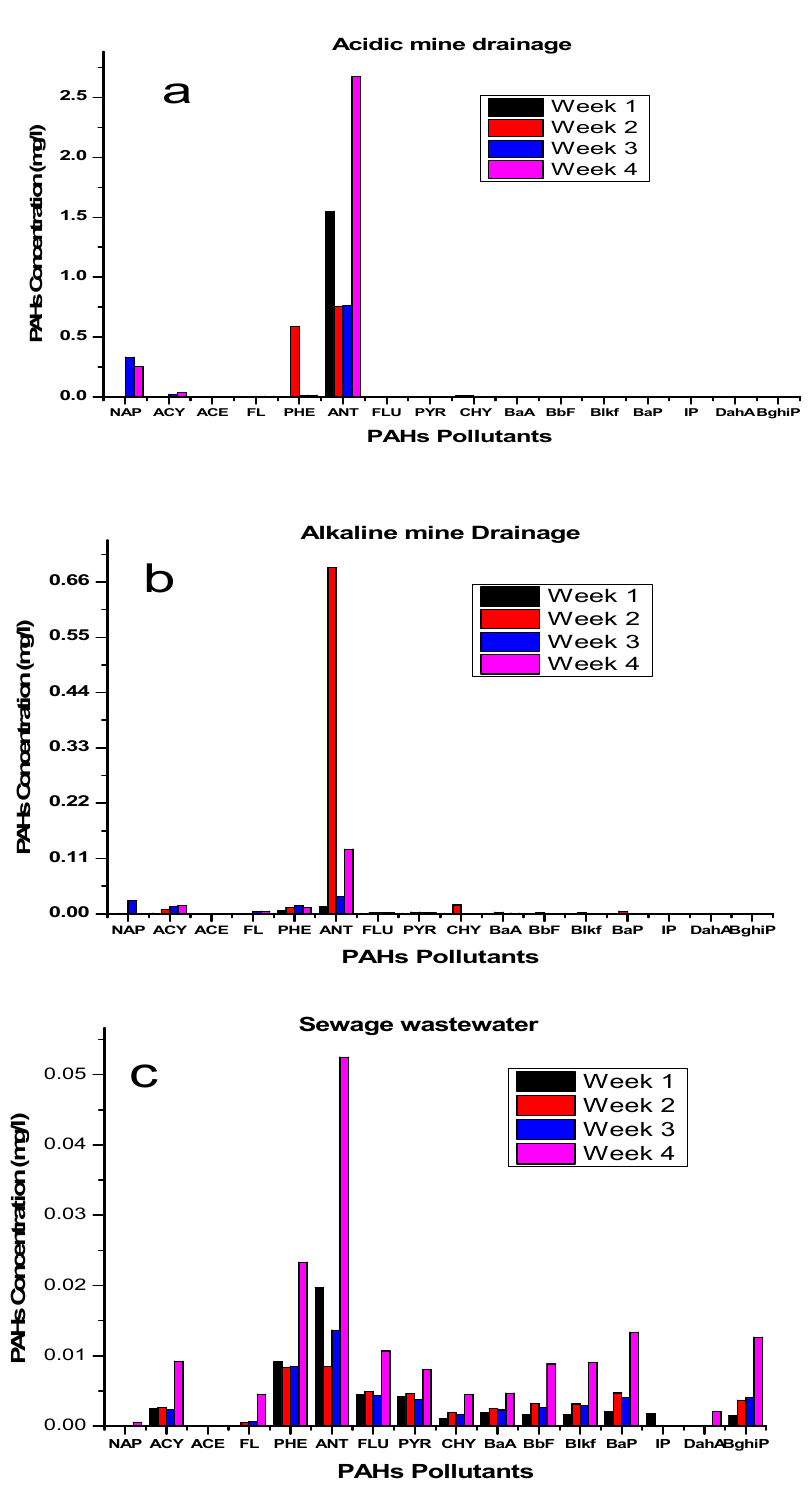
Figure 5. Ageing of PAHs in acidic medium ( a ), alkaline medium ( b ), and sewage medium ( c ).